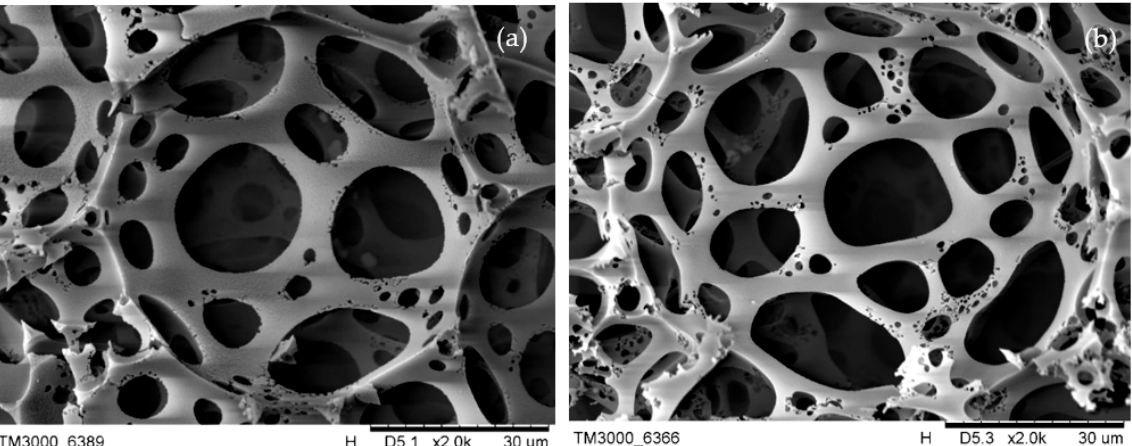
Figure 5. Scanning electron micrographs of poly(S/DVB)HIPE: ( a ) unmodified S/DVB 80:20 ( × 2000); ( b ) modified S/DVB 80:20 ( × 2000).